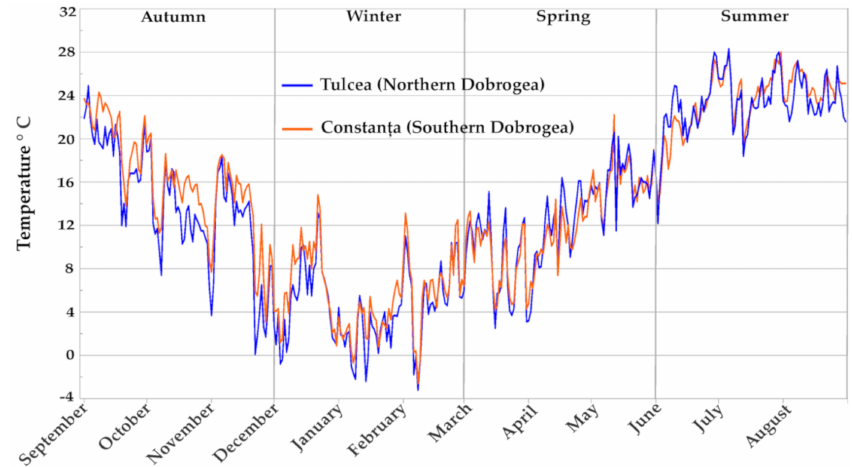
Figure 4. Daily mean temperature from Northern and Southern Dobrogea (Tulcea and Constanta meteorological stations) between September 2019 and August